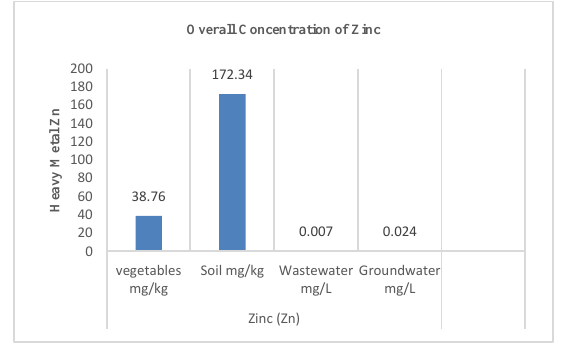
Figure 3: Overall Concentration of Zinc